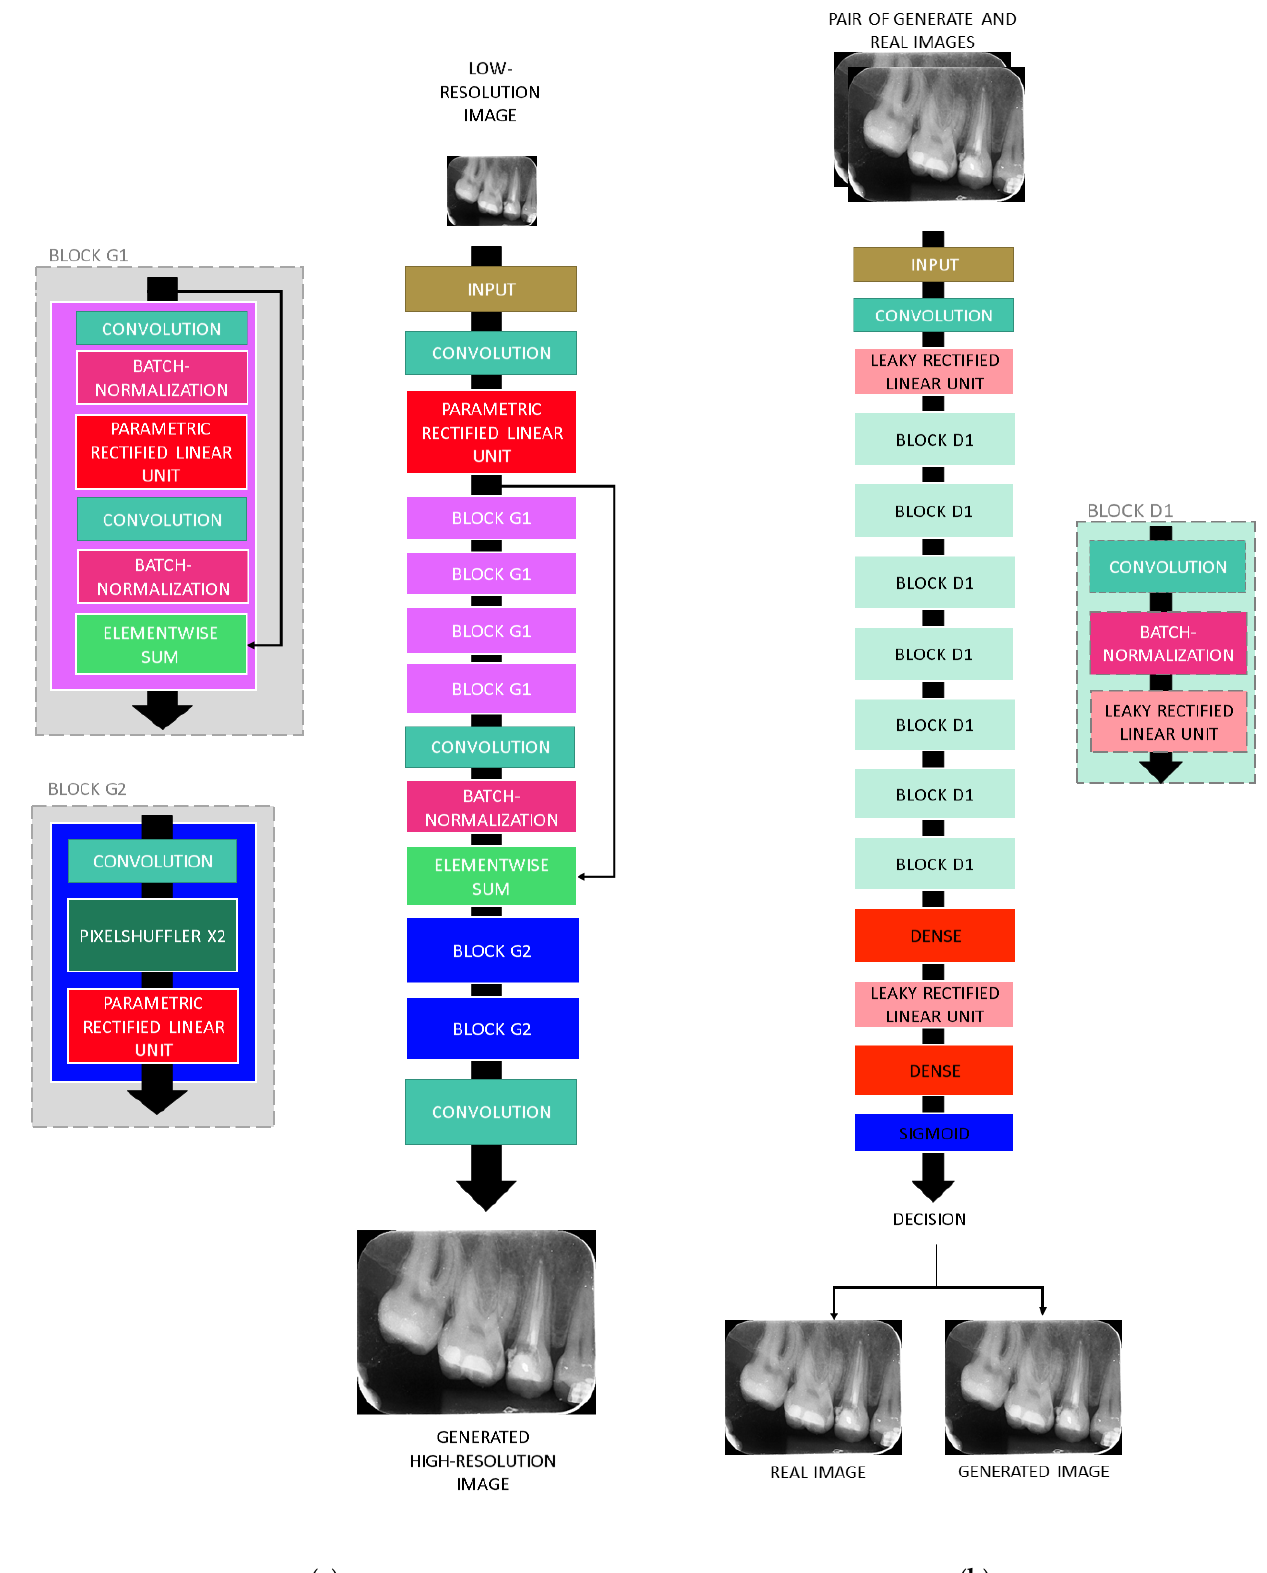
Figure 3. SRGAN architecture: ( a ) generator network and ( b ) discriminator network.